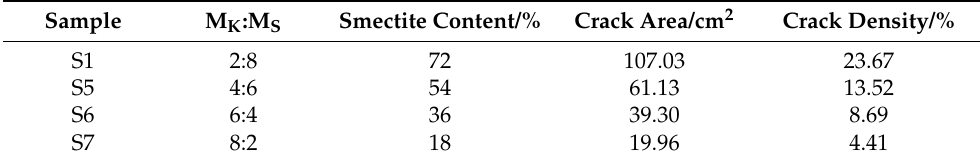
Table 6. Crack area and density under different quality ratios of kaolin to